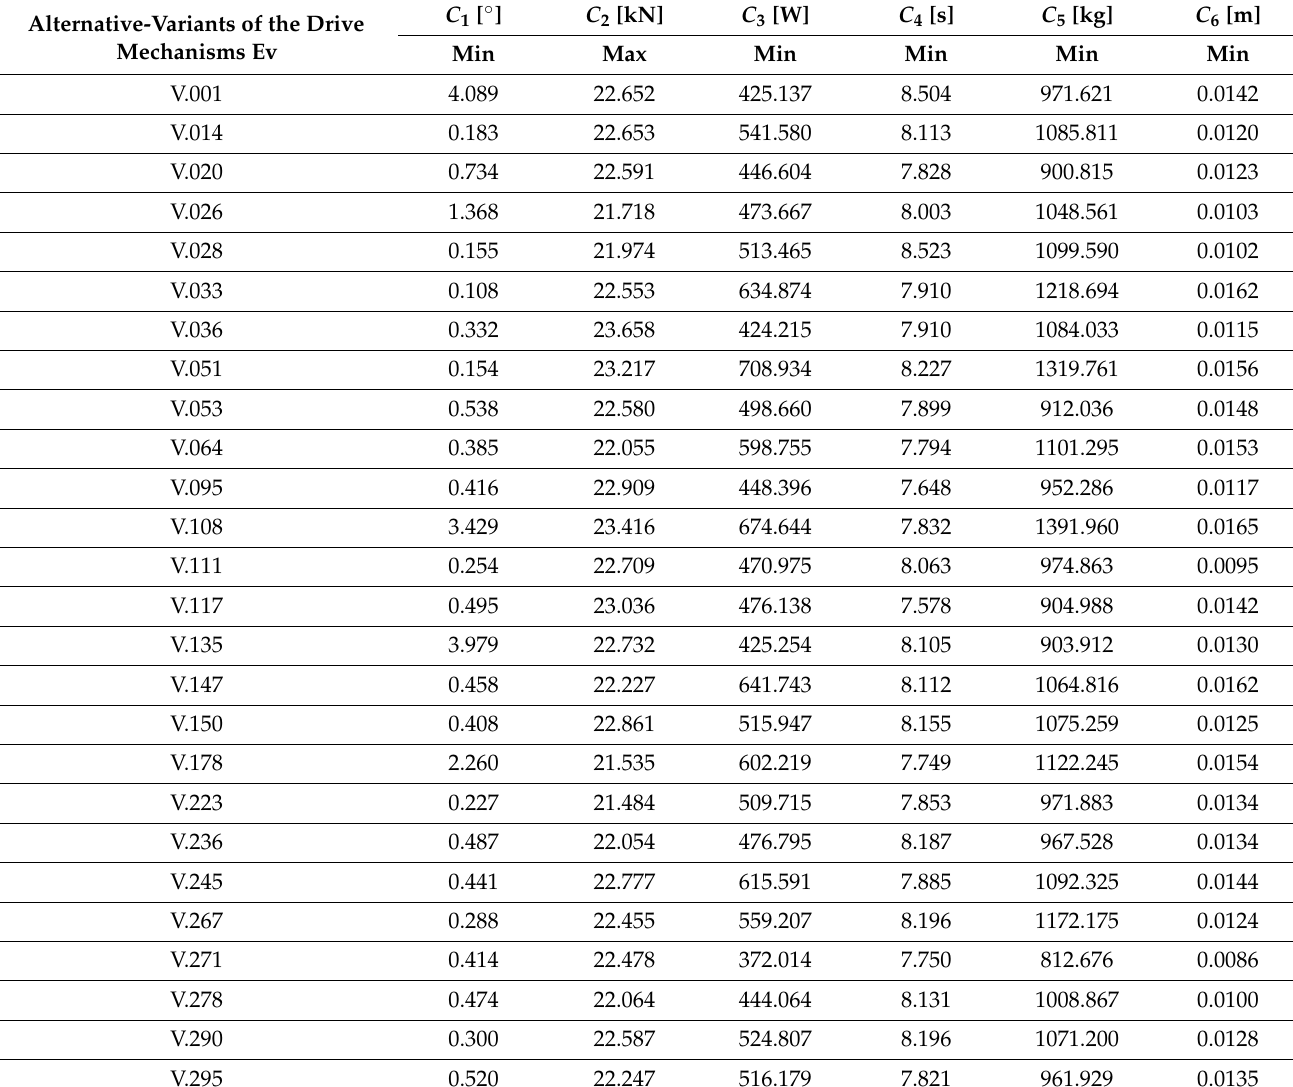
Table 3. Loader mechanisms